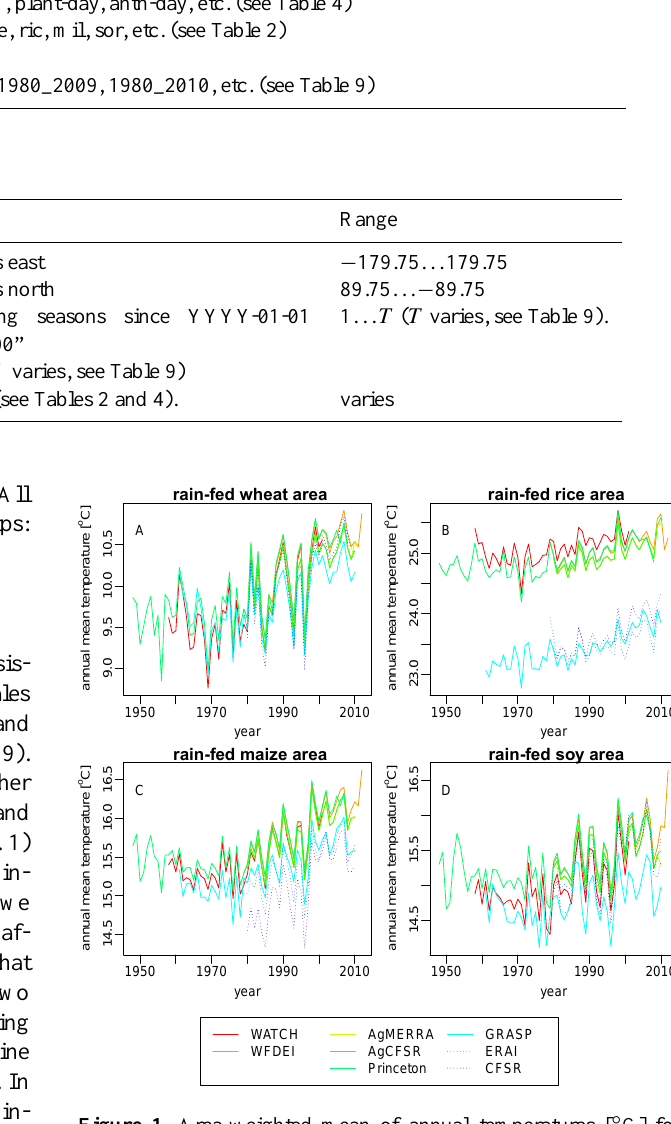
Figure 1. Area-weighted mean of annual temperatures [ ◦ C] for cropping areas for rain-fed wheat (a) , rice (b) , maize (c) , and soy (d) .